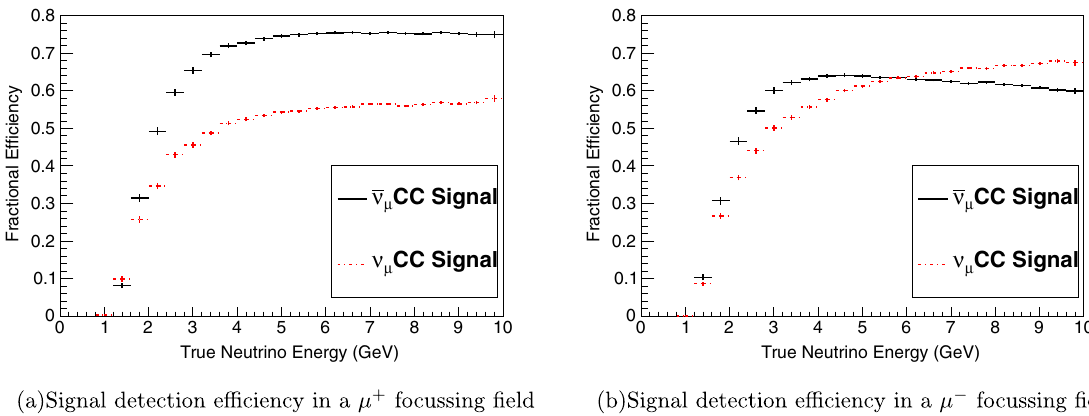
FIG. 9. Efficiency for the detection of (cid:3) (cid:4) and (cid:2) (cid:3) (cid:4) charge current detection assuming the two different magnetic field configurations.